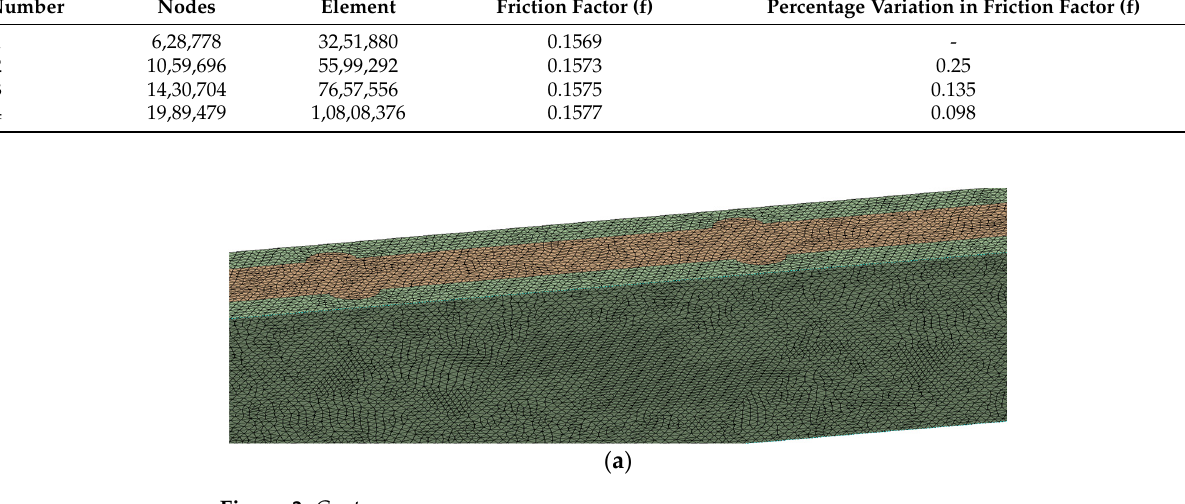
Table 4. Grid independent test.